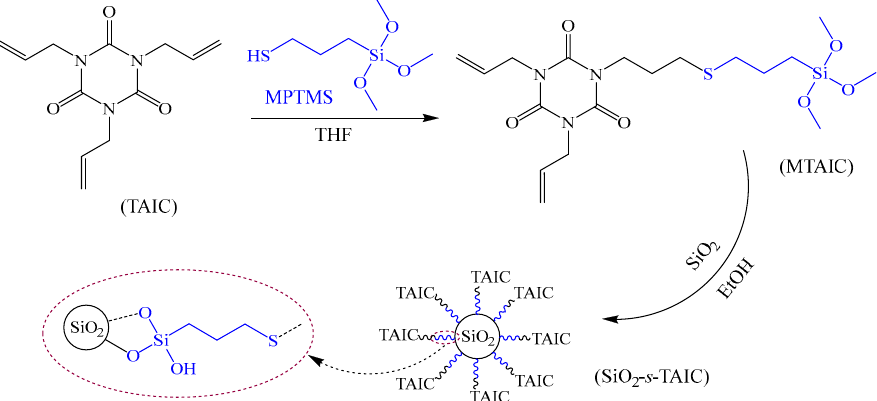
Table 1. Molecules 2020 , 25 , x FOR PEER REVIEW